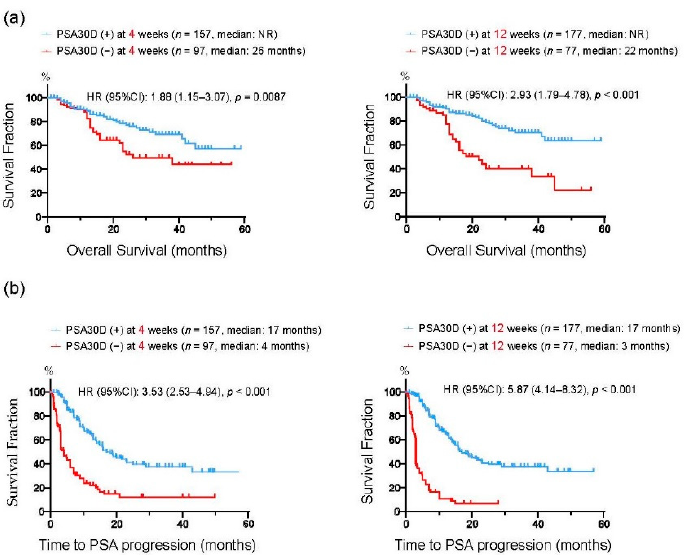
Figure 4. Kaplan-Meier curves for overall survival (OS) ( a ) and time to PSA progression (TTPP) ( b ) from the initiation of the first-line ASIs. In each figure, patients were divided into two groups according to the achievement of >30% PSA decline (PSA30D) at 4 weeks or 12 weeks of the treat- ment. Table 2. Multivariate analysis for OS in 254 mCRPC patients treated with AA or Enz at the first- line treatment.